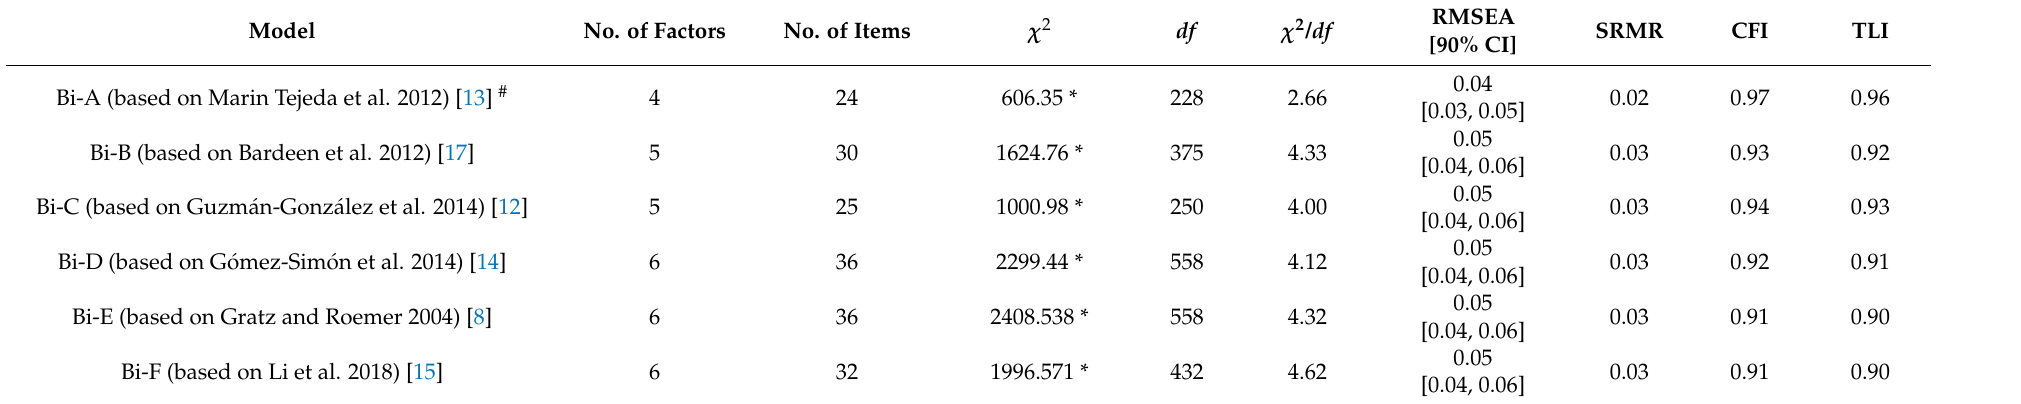
Table 5. Bifactor CFA model-fit results of the suggested structures of the DERS ( N = 1036). Model No. of Factors No. of Items χ 2 df χ 2 / df